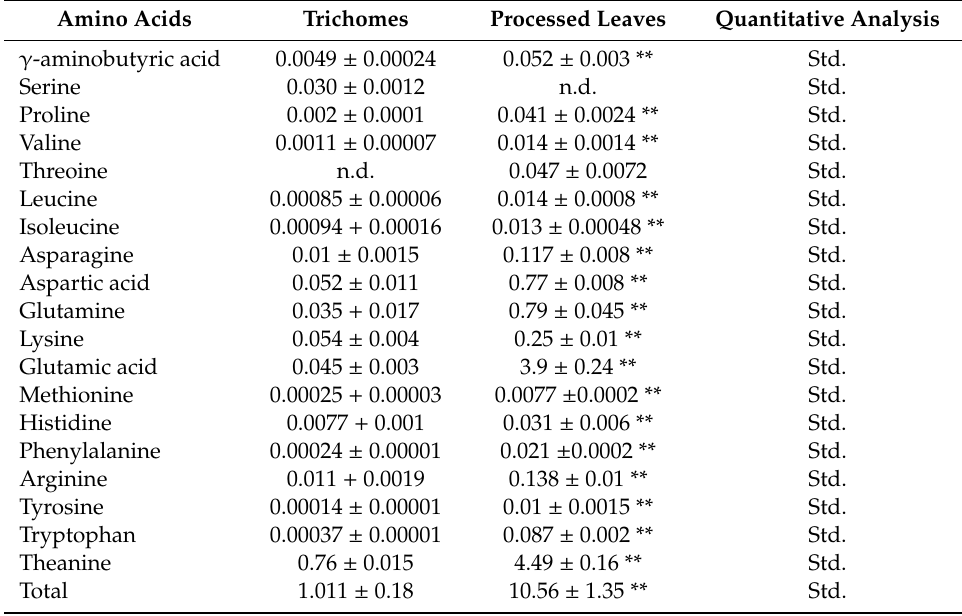
Table 1. Contents of amino acids in trichomes and processed leaves (mg / g dry weight).